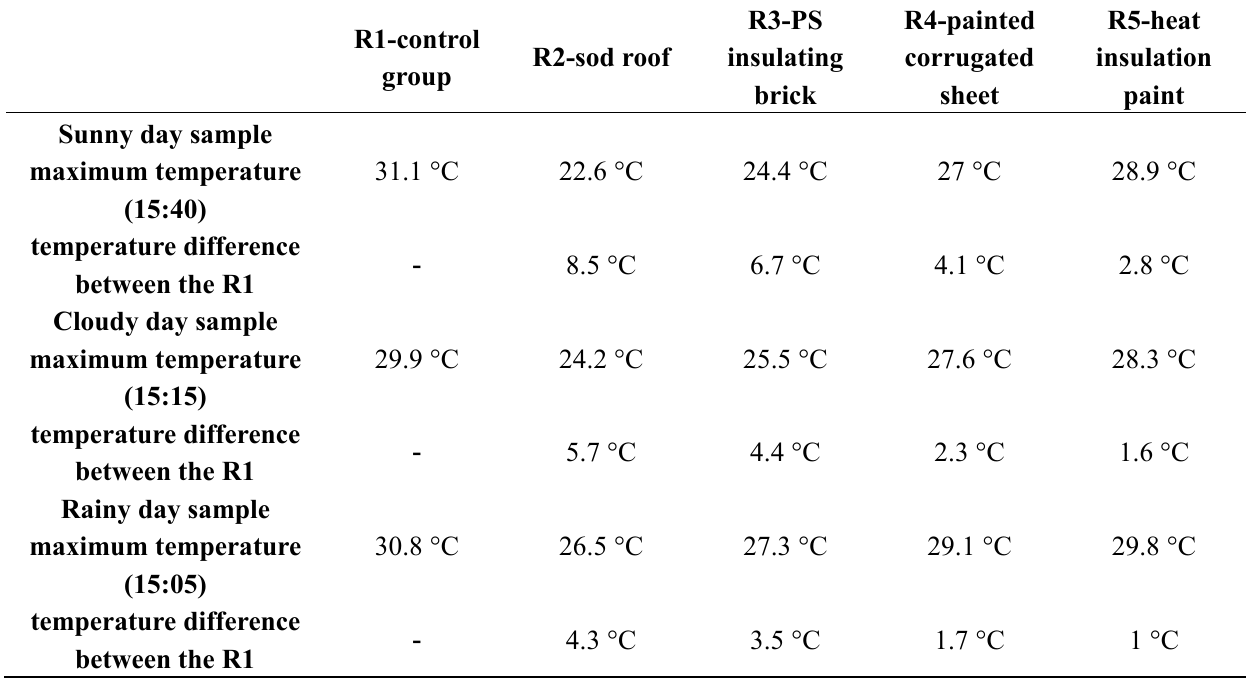
Table 2. Efficacy comparisons of roof thermal insulation materials.